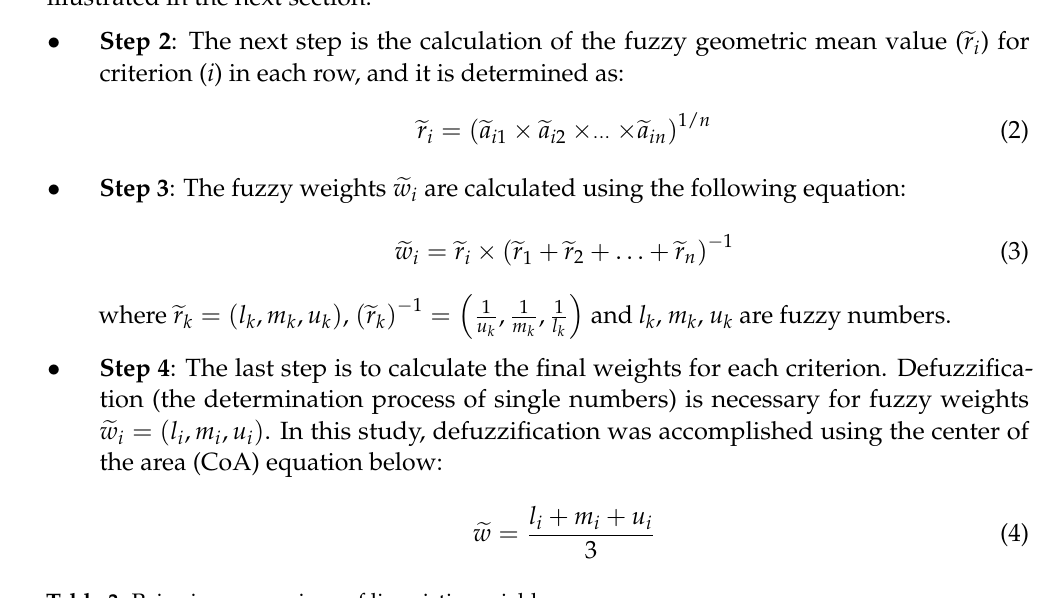
Table 3. Pairwise comparison of linguistic